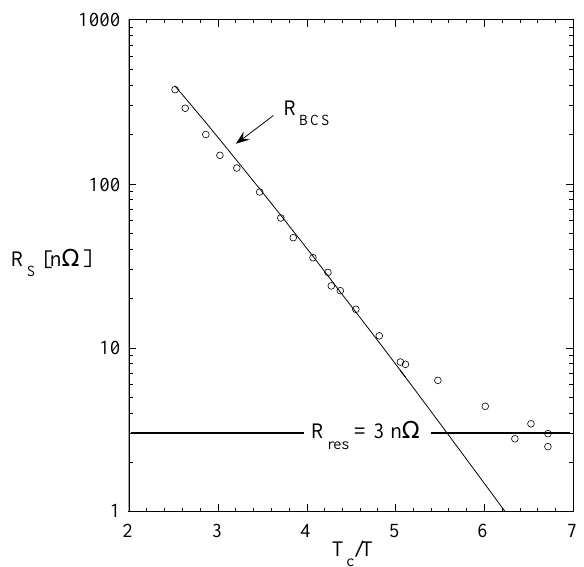
FIG. 1. The surface resistance of a 9-cell TESLA cavity plot- ted as a function of T c (cid:1) T . The residual resistance of 3 n V corresponds to a quality factor of Q 0 (cid:1) 10 11 .